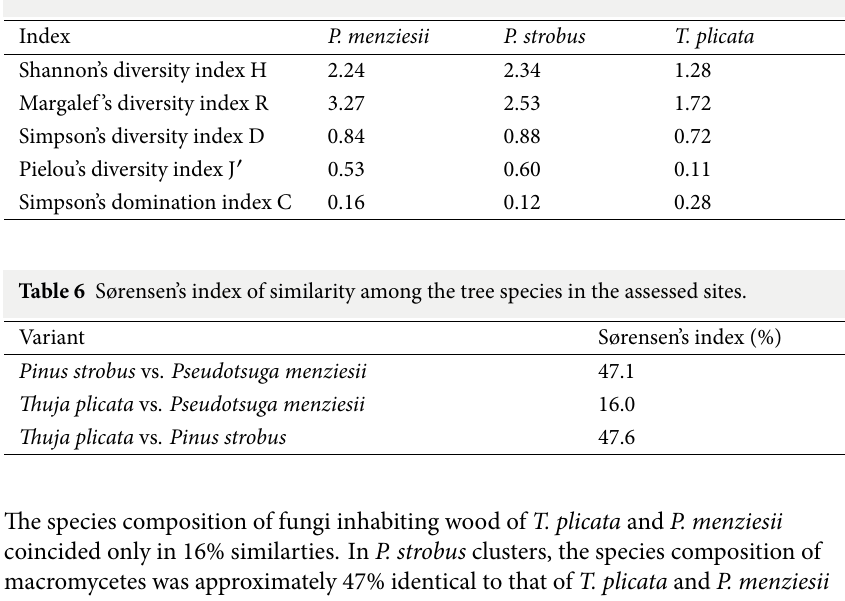
Table 5 Ecological index values for Pseudotsuga menziesii , Pinus strobus , and Thuja plicata trees in the assessed sites.